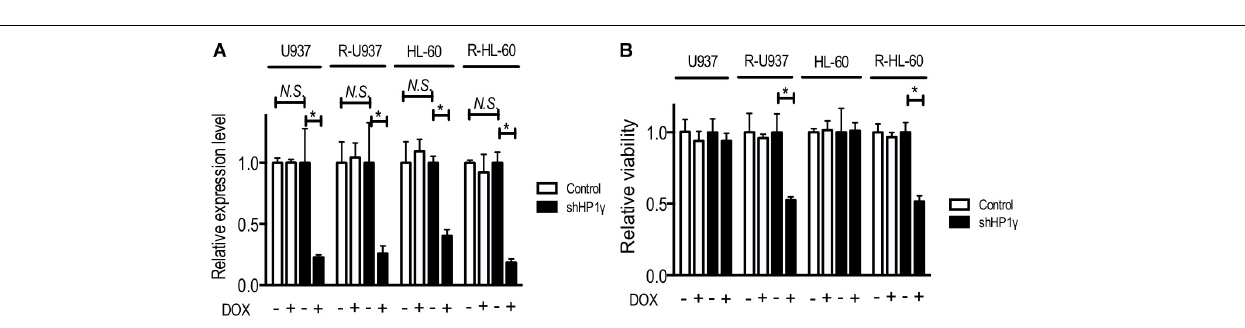
FIGURE 2 | (A) Relative mRNA expression of HP1 γ after incubation with (+) or without (–) 1 µ g/ml doxycycline (DOX) for 72 h in control plasmid–infected cells (white bars) and shHP1 γ -infected cells (black bars). The means ± SD from three independent experiments are shown. ∗ p < 0.0001. (B) The relative viability of control plasmid–infected cells (white bars) and shHP1 γ -infected cells (black bars) after incubation with (+) or without (–) 1 µ g/ml DOX for 96 h. The means ± SD from three independent experiments are shown. ∗ p <